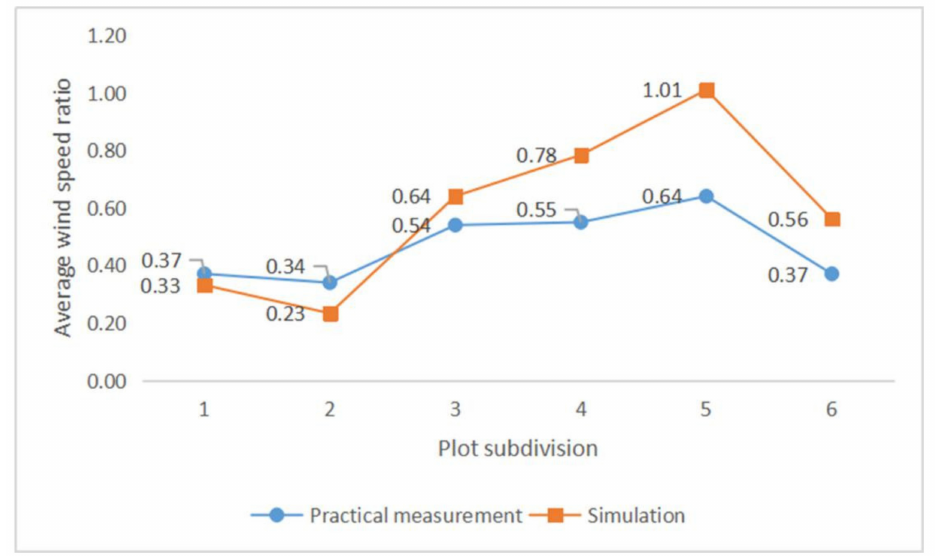
Figure 13. Average wind speed ratio of practical measurement and simulation results in southeast